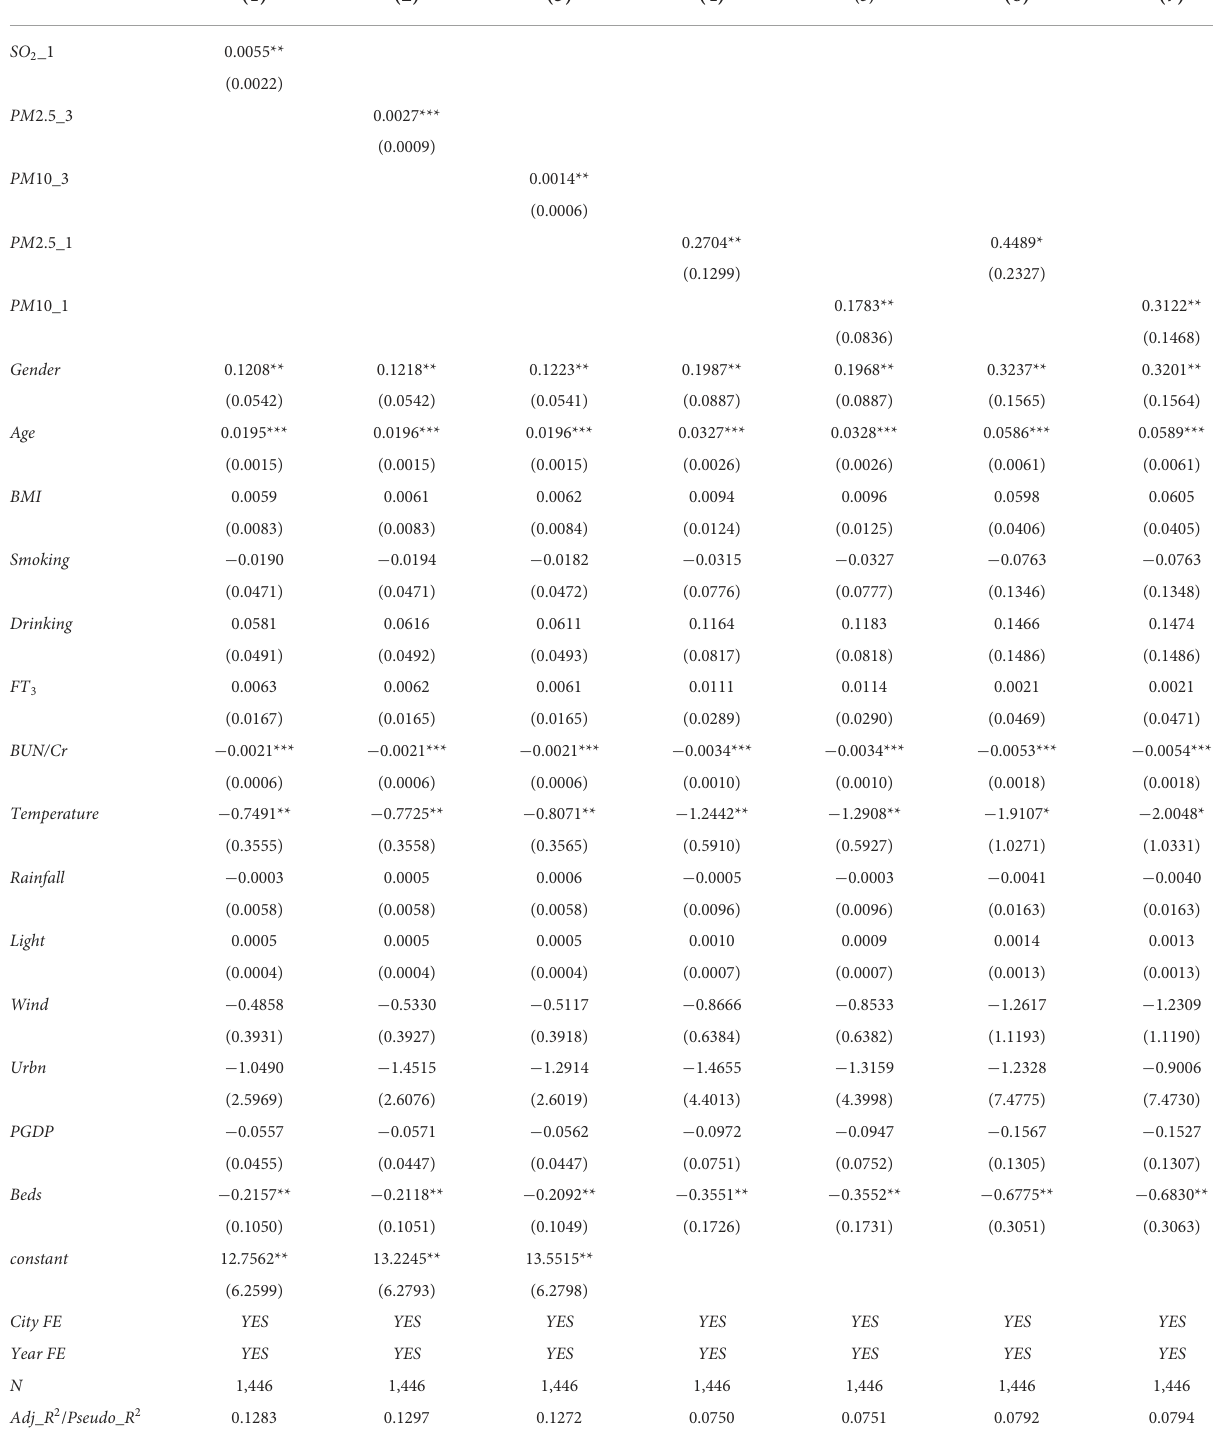
TABLE 4 Robustness test of substitution variables and transformation regression